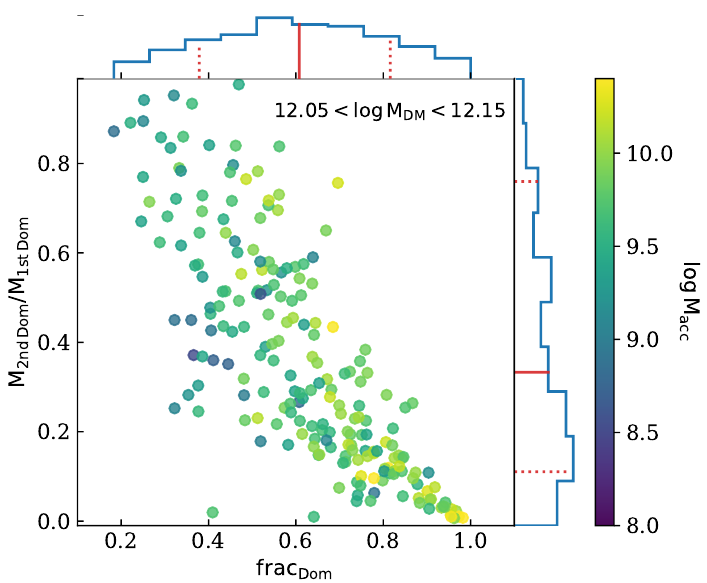
Figure 1. Stellar halos are predicted to have accreted their mass from the few largest, and in many cases the single largest, satellite(s). The x -axis shows frac Dom , the fraction of the accreted mass given by the single-most massive disrupted satellite as predicted by the Illustris hydrodynamical simulation [10,24] for a sample of simulated galaxies with dark matter halo masses similar to the Milky Way (12.05 < log M DM / M < 12.15). The y -axis shows the ratio of the second-most massive (cid:12) to the most massive progenitor. Symbols are color-coded by the total accreted mass. Marginalized distributions of each quantity are shown, along with the 16, 50, and 84 percentiles of the distributions. The stellar halos of Milky Way (MW) peers are expected to show a wide range of properties, from the less-common halos built up from multiple smaller accretions (top left) through to the more common halos completely dominated by a single massive accretion (bottom right).